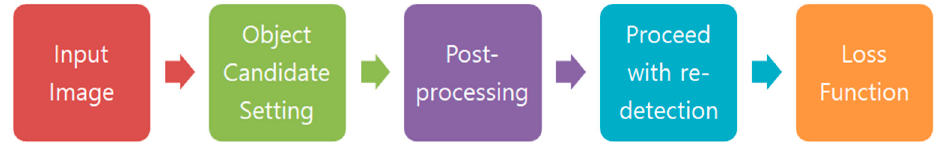
Figure 4. Hybrid human detection 4-step workflow.